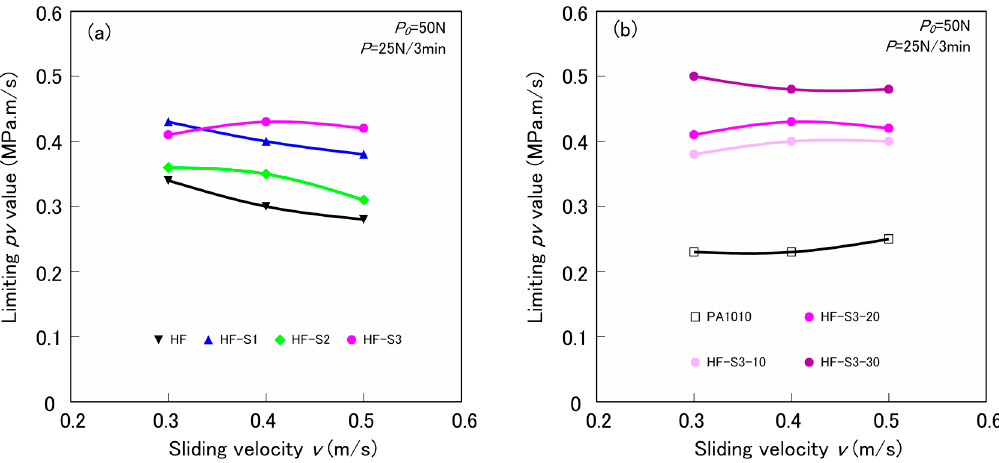
Figure 11. Limiting pv value as a function of sliding velocity v for various surface-treated HF/PA1010 biomass composites: ( a ) Influence of type of silane coupling agent and ( b ) Influence of volume fraction of HF.